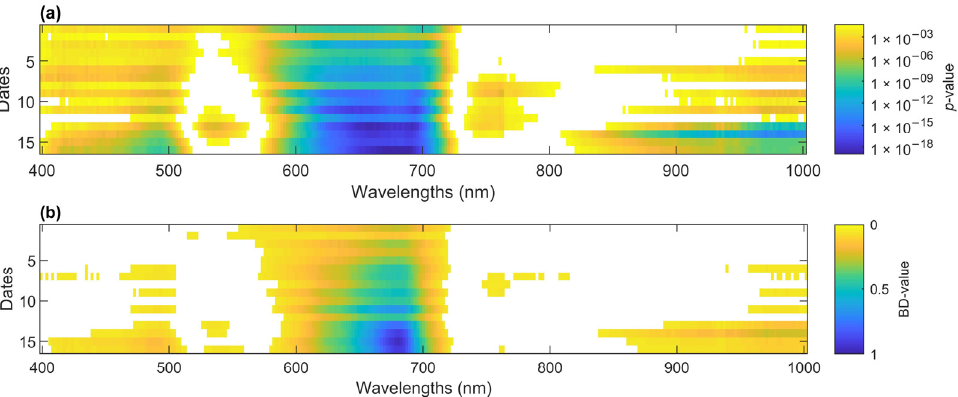
Figure 6. ( a ) p -value of 2-sample t -test to assess the relative importance among wavelengths to distinguish inoculated from control seedlings over time. Cooler colors represent smaller p -values. In white are non-significant wavelengths ( p > 0.05). ( b ) Bhattacharyya distances of wavelengths over time between distributions of reflectance for inoculated and control seedlings. This is an indicator of how successful a wavelength is at separating infected from control seedlings (1 is successful and 0 is unsuccessful). In white are BD-values < 0.05.